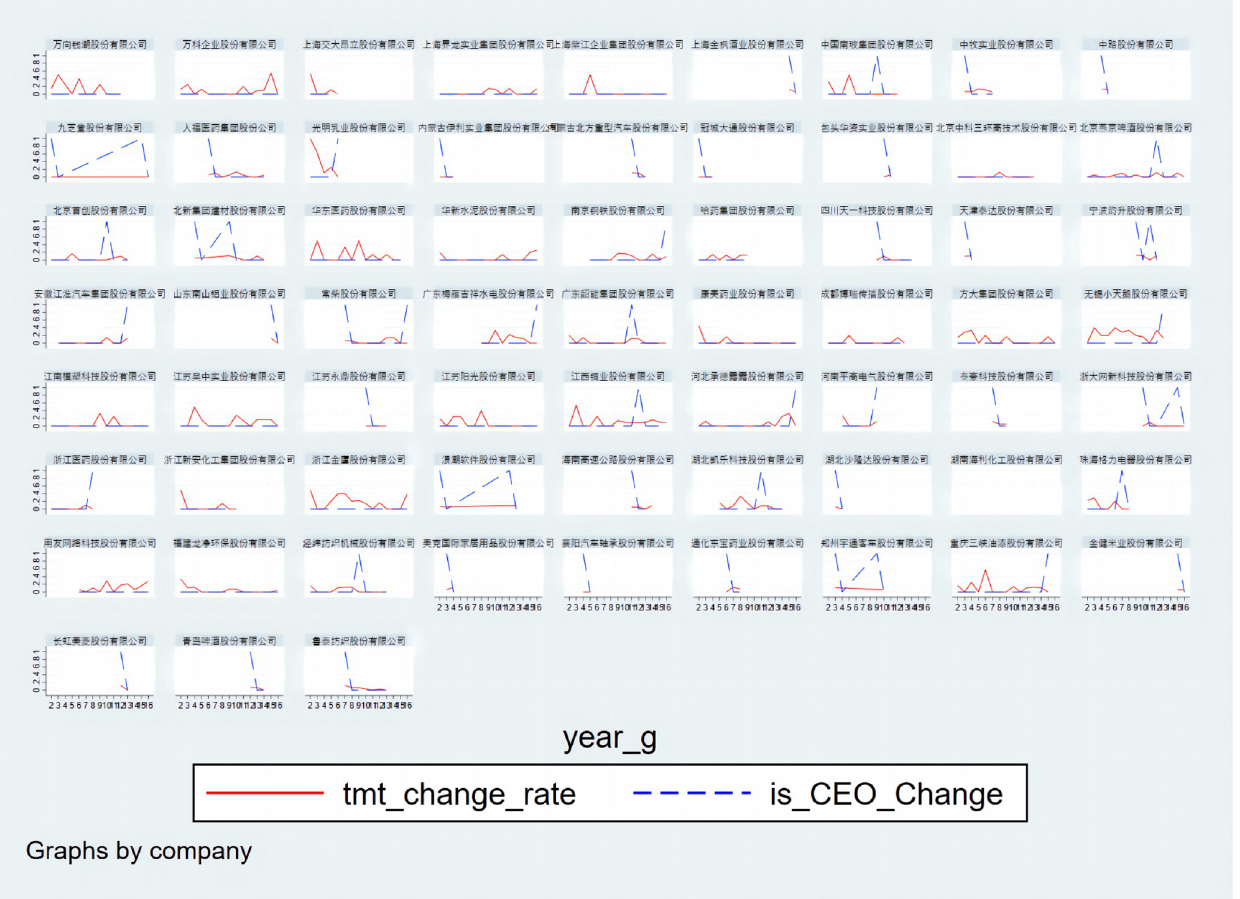
Fig 3. The change rate of the CEO and Top management team in the filtered